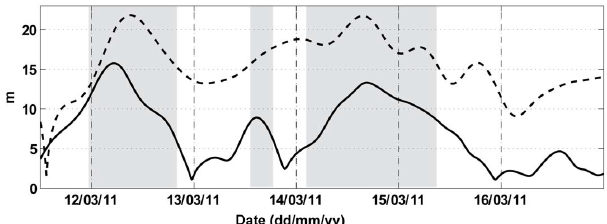
Figure 7. Estimates of the surface (continuous line) and bottom (dashed line) Ekman depths (m). The gray patches show the periods where the sum of the surface and bottom Ekman depths exceeded 24m (the water depth at station A2). The date indicates